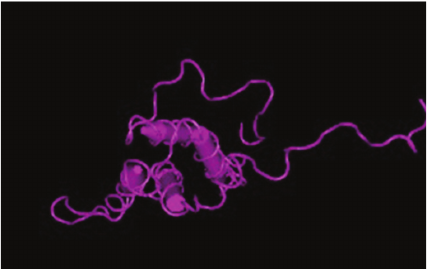
Figure 5: Ara h 6 (PDB Entry 1W2Q, first molecule in the entry).